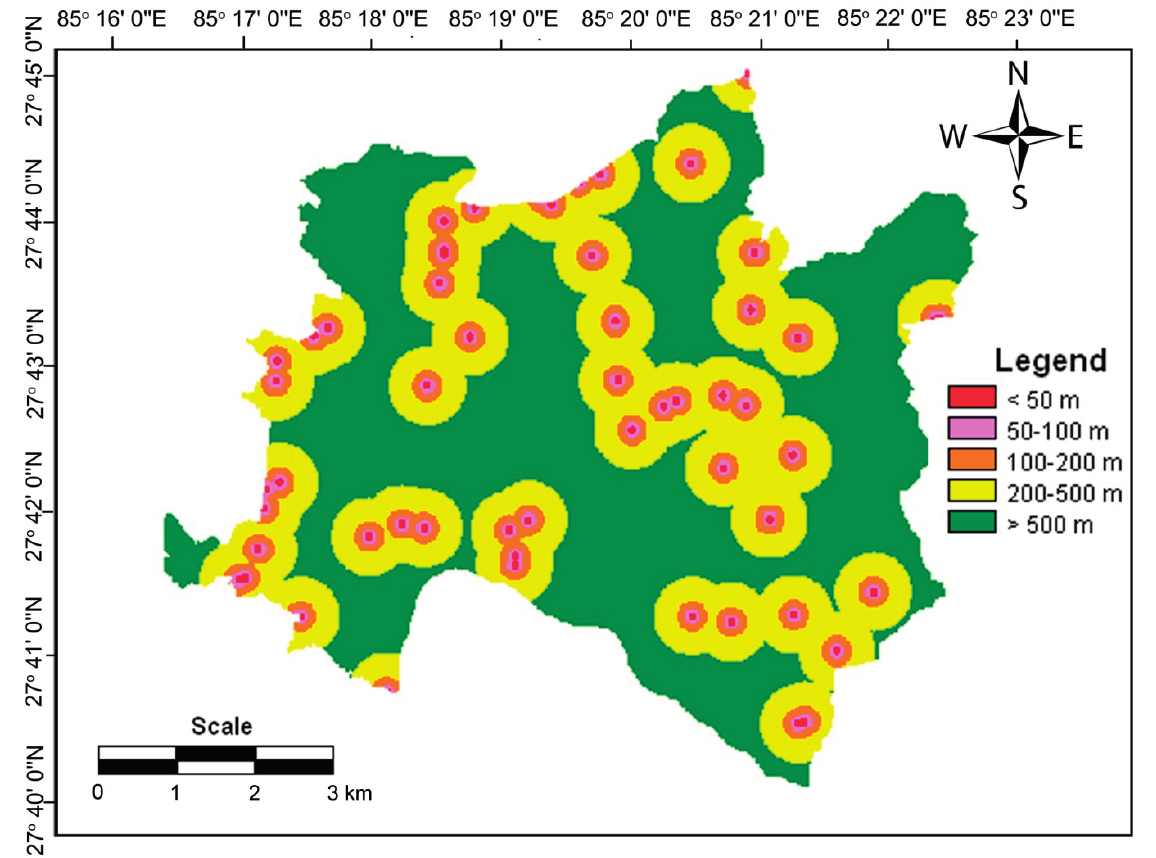
Figure 3. Map showing distance from fuel stations in the study